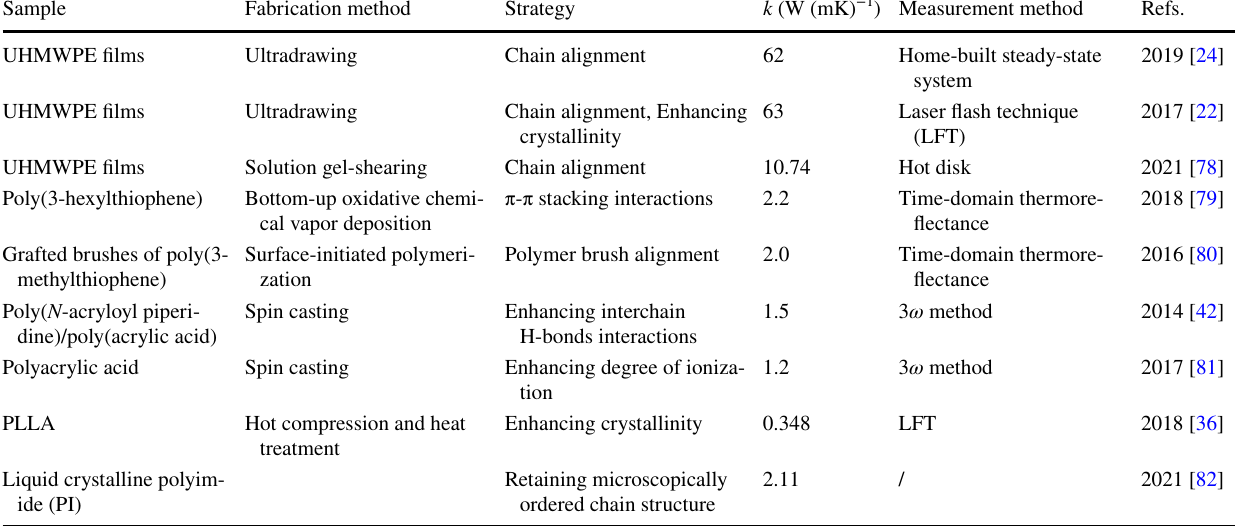
Table 2 The summary of pure polymer films with high intrinsic k